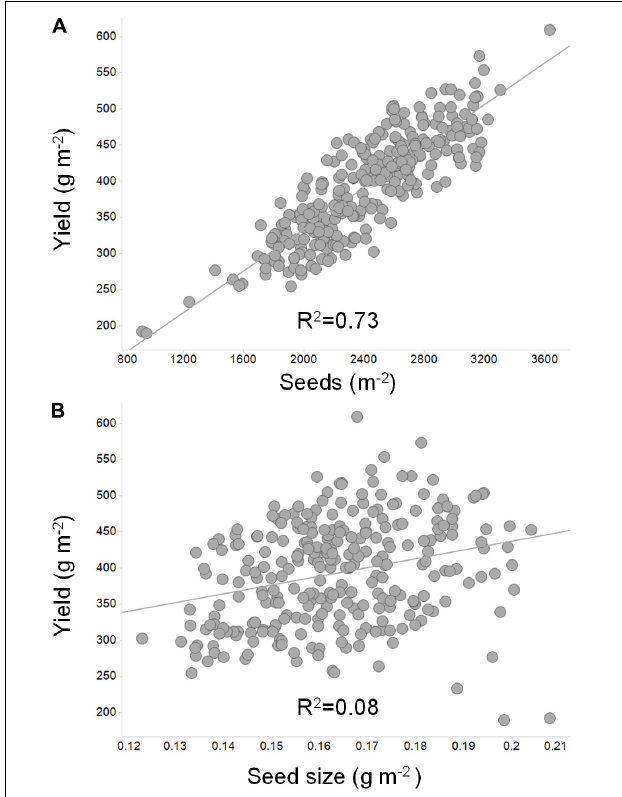
FIGURE 3 | An illustration of the relationship of seed number and seed size to soybean yield. Linear correlations were derived between yield, seed number, and seed size to depict the more significant relationship to yield for (A) seed number as compared to (B) seed mass. In this example, 40 soybean lines adapted to the Midwest US were grown in replicated field plots at seven locations across Illinois, Indiana, and Missouri (Uniform Soybean Tests: Northern Region 2019; Uniform Test III – Treated Material; https://purr.purdue.edu/publications/3416/1). Seed number per unit area was calculated based on average yield per location divided by average seed size (Nowling and Guohong,